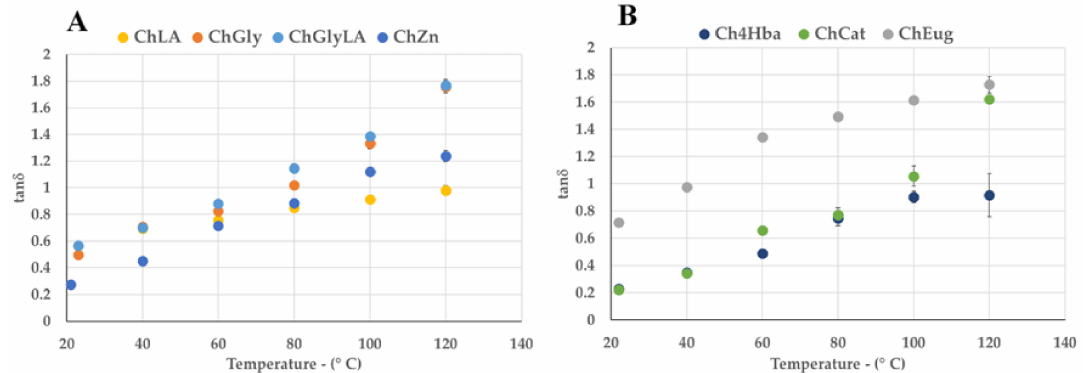
Figure 2. Variation of tan δ (@2.45 GHz) according to temperature. ( A ): NaDESs (ChLA, ChGly, ChGlyLA and CHZn); ( B ): LigDESs (Ch4Hba, ChCat and